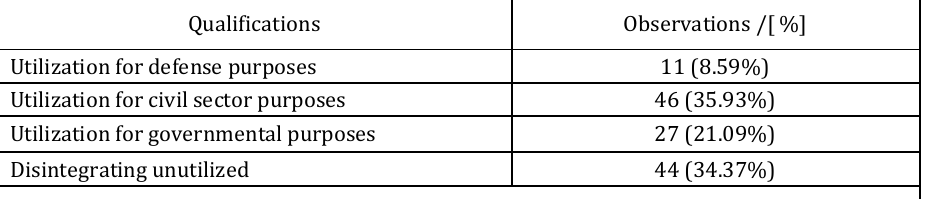
Table 2. Proportion without of garrisons in outside Budapest (Source: author’s research, 2022) Qualifications Observations /[ %]